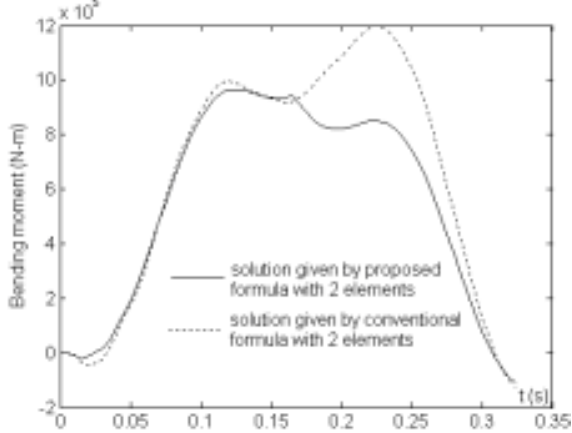
Fig. 10. Time histories for bending moment at the midpoint cross-section of beam with the solutions given by the proposed formula and by the conventional formula with 2 elements.